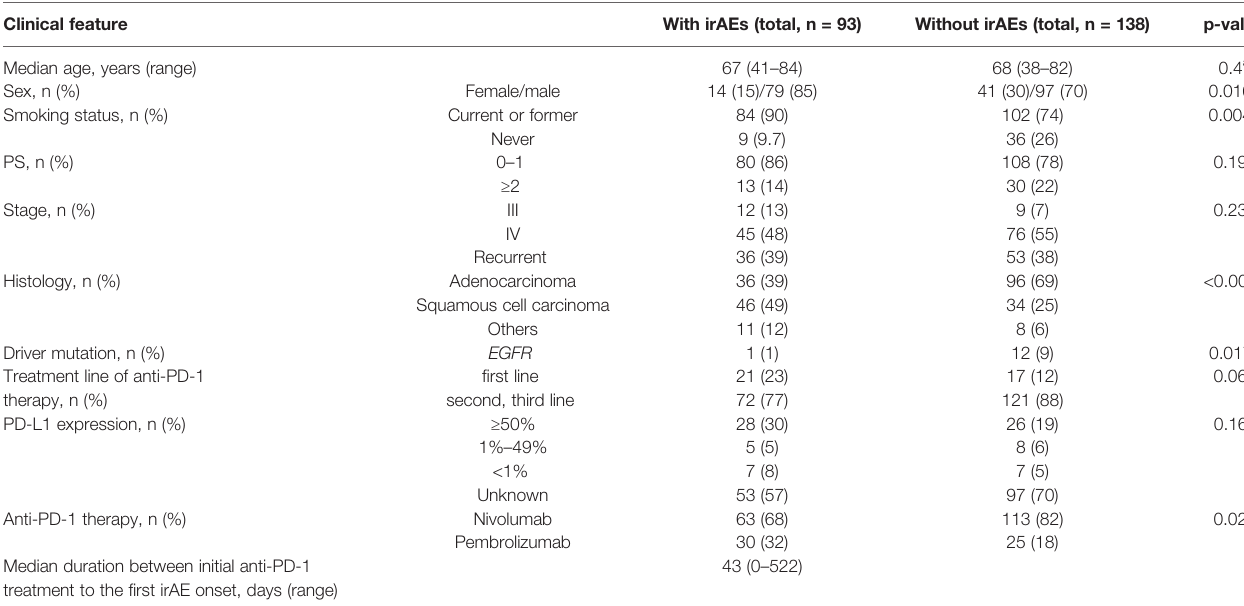
TABLE 1 | Patients ’ characteristics at anti-PD-1